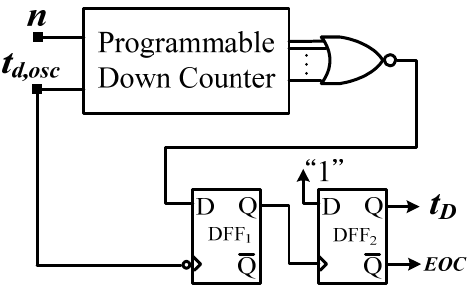
Figure 6. Structure of adopted time